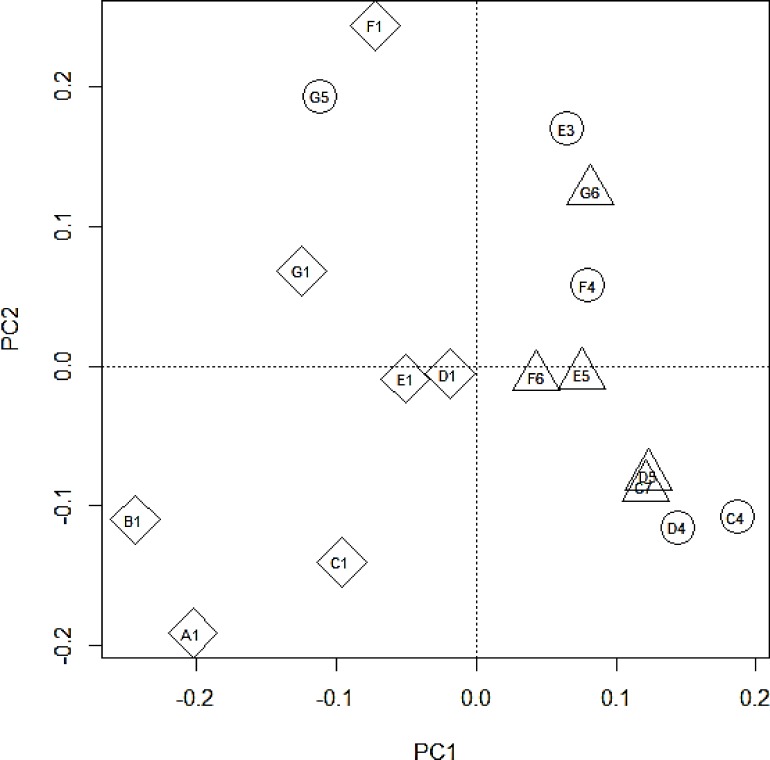
Principal component analysis (PCA) ordination of Wisconsin standardised environmental data at each site sampled.(Triangle = oceanic stations, circle = shelf break stations, diamond = shelf stations).